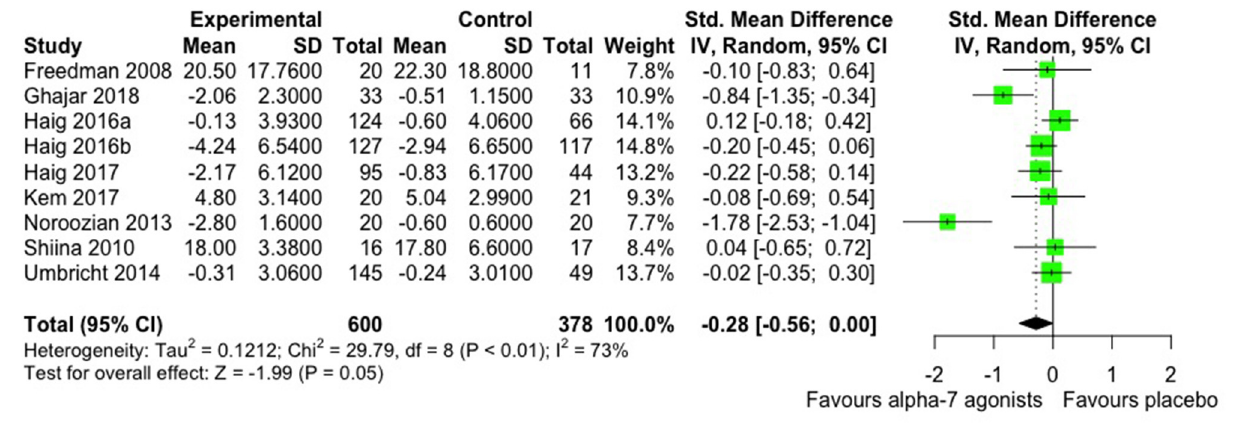
FIGURE 4 | Overall efficacy in negative symptomatology of antipsychotic drug plus α -7 nAChR agonists vs. antipsychotic drug plus